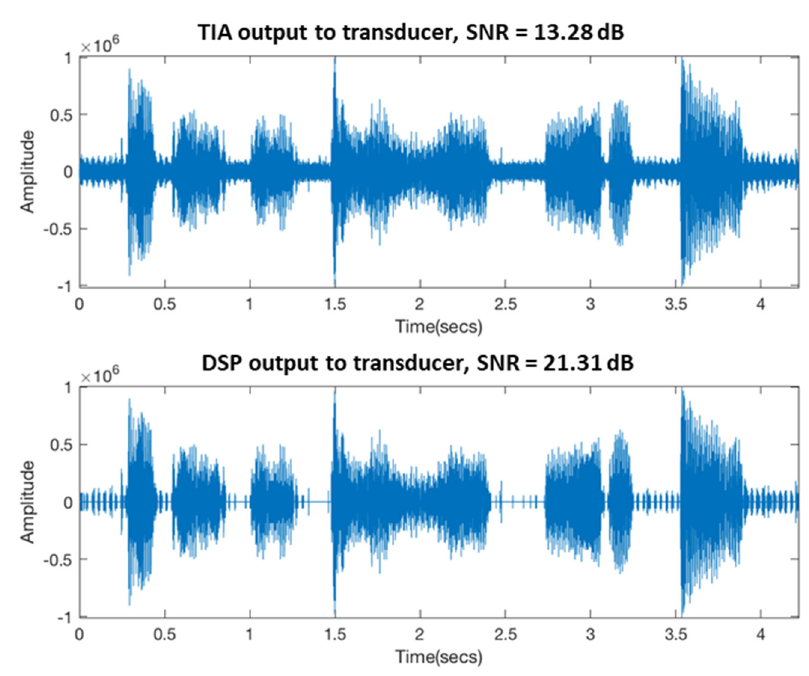
Figure 18. Time − domain signal of vibration of Figure 18 . Time − domain signal of vibration of BCT.